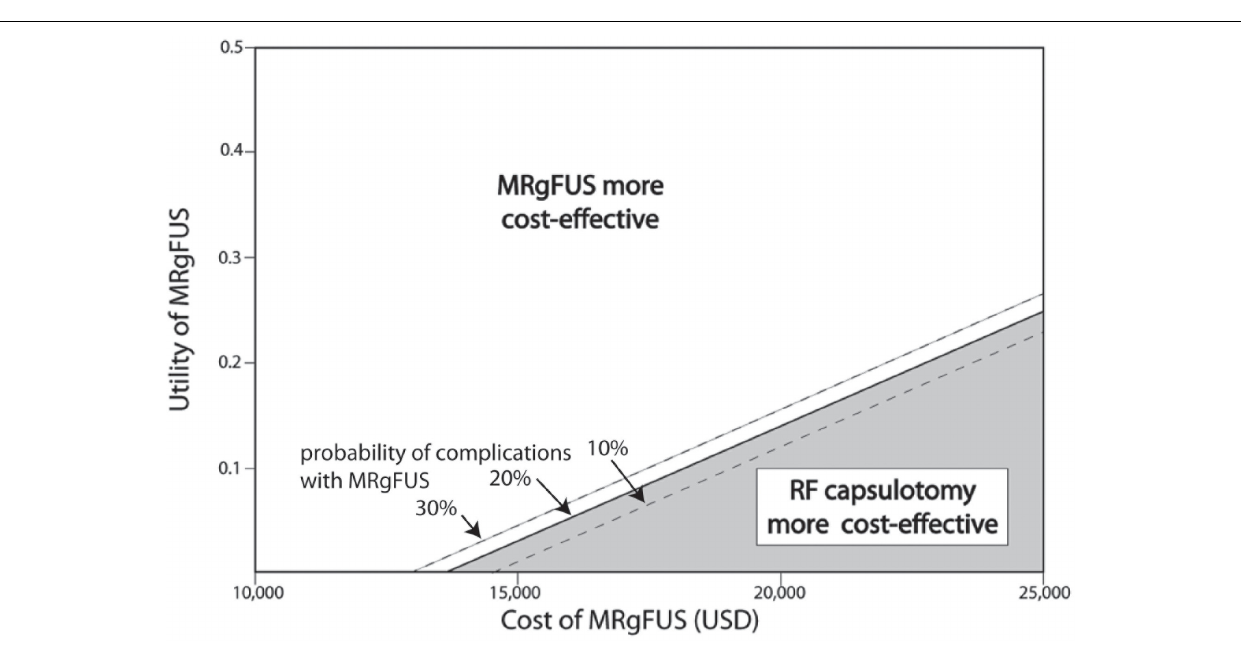
FIGURE 2 | MRgFUS capsulotomy is a cost-effective therapy for treatment-refractory OCD under a wide range of parameters. Sensitivity analysis of each MRgFUS parameter yielded effectiveness (utility of MRgFUS), cost (USD) and complication rate (%) as the most important parameters in determining the cost-effectiveness threshold between MRgFUS and RF capsulotomy. OCD, obsessive-compulsive disorder; MRgFUS, magnetic resonance guided focused ultrasound; RF,